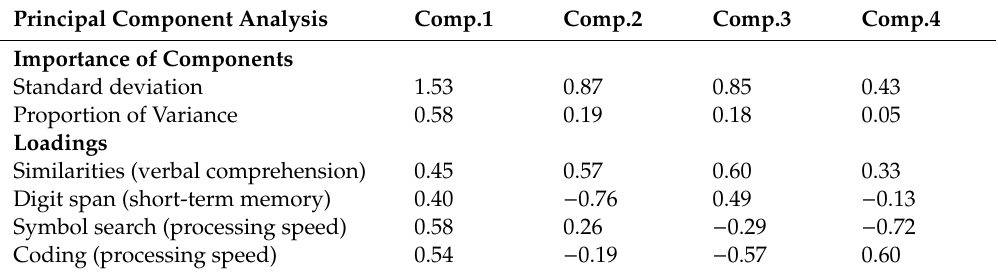
Table A1. Results of the Principal Component Analysis over the data of four variables relating to general cognitive ability.